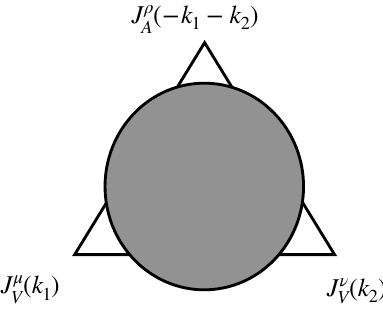
Figure 1 . The triangle diagram of AVV three-point function, where the shaded center area implies strong-coupling, contrasting with one-loop weakly-coupled